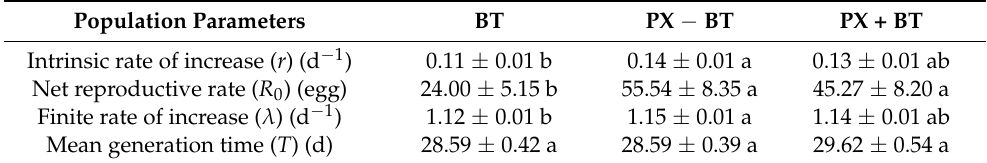
Table 2. Population parameters (M ± SE) of Bemisia tabaci when feeding on Chinese kale alone (BT), with prior DBM damage (PX − BT) or with simultaneous DBM damage (PX + BT). Population